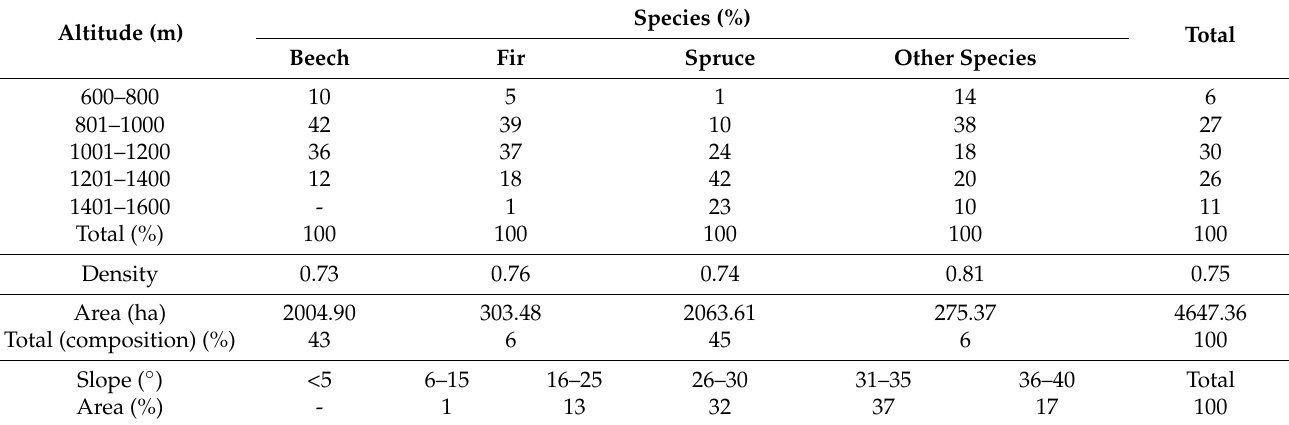
Table 1. Species and slope distribution in relation to